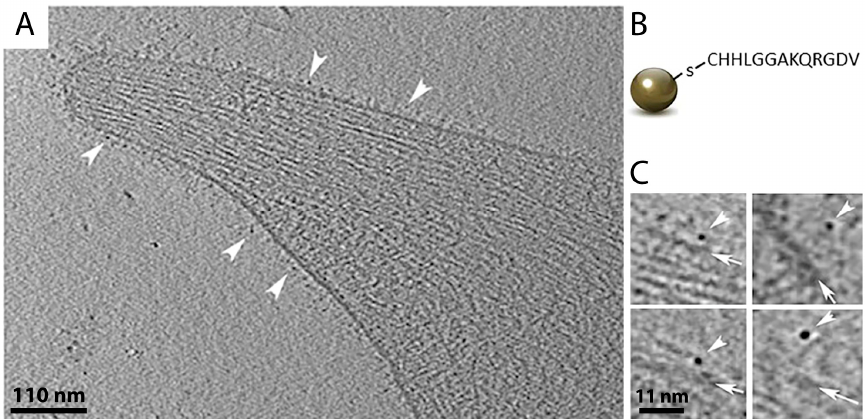
Figure 6. Gold nanoparticles in cryo-ET. ( A ) A 1.2 nm thick slice through a cryo-tomogram of a membrane protrusion of a human platelet cell. Gold nanoparticles bound to integrin receptors on the plasma membrane are indicated by white arrowheads. ( B ) Schematic view of a 2.2 nm gold nanoparticle conjugated to a peptide chain that binds to integrin receptors. ( C ) Gold nanoparticles (white arrowheads) coupled to integrin receptors at the plasma membrane (white arrows) of platelet cells. Figure was modified from [116] .